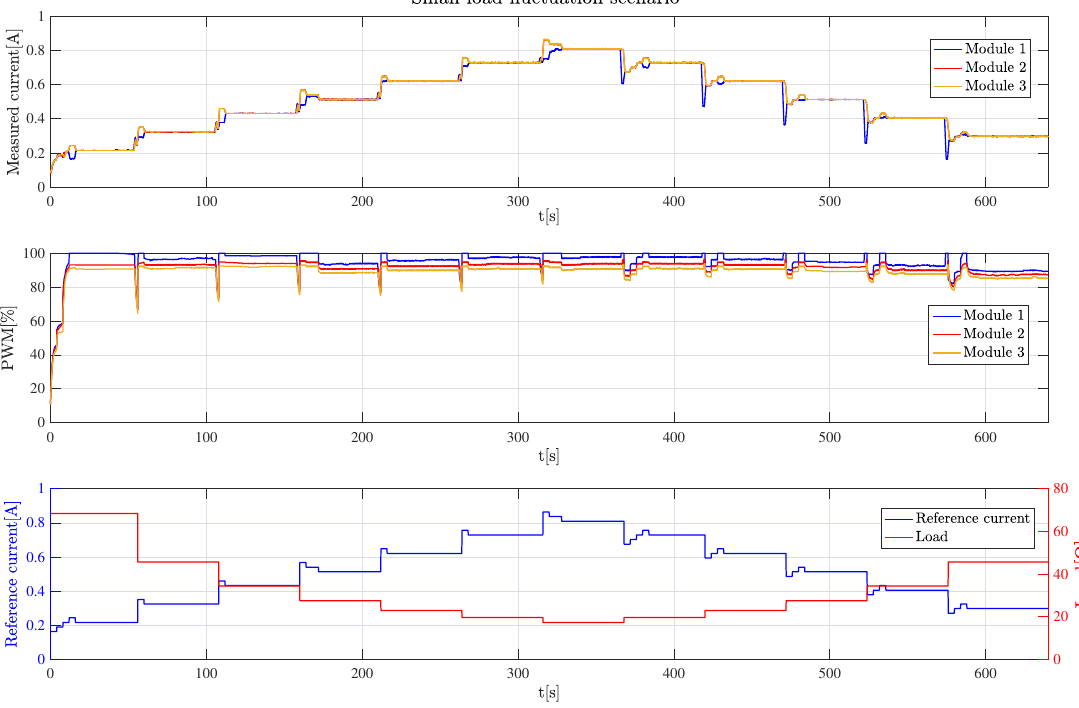
Figure 9. Currents ( top ) and modulation of battery voltages ( middle ) in battery modules for autonomous module current scheduling of three parallel placed battery modules with same battery capacity, reference current and time-varying external load impedance ( bottom ) under small load fluctuation